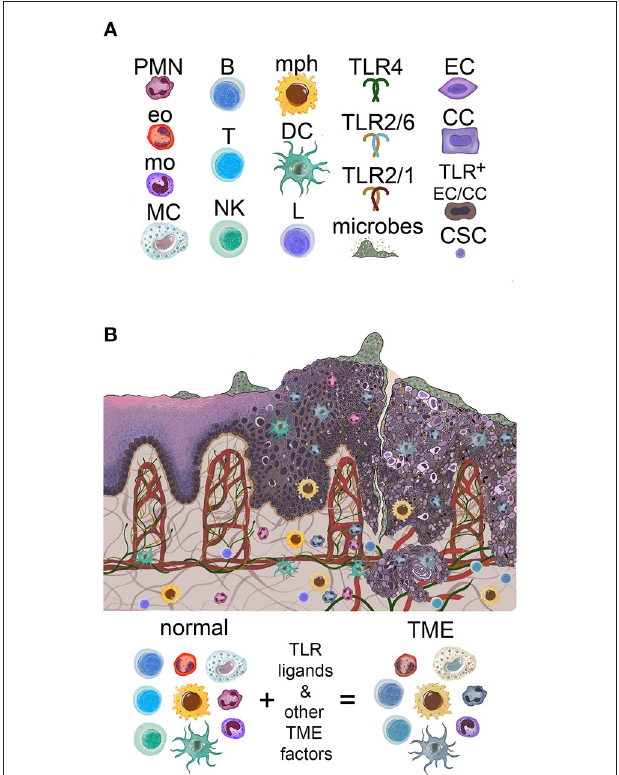
FIGURE 1 | Overview of the oral mucosal environment in the evolution of oral squamous carcinogenesis. (A) Icons used to depict components of the figures in this review. PMN, neutrophil; Eo, eosinophil; mo, monocyte; MC, mast cell; B, B cell; T, T cell; NK, NK cell; mph, macrophage; DC, dendritic cell; L, lymphocyte; TLR, toll-like receptor; EC, epithelial cell; CC, cancer cell; CSC, cancer stem cell. (B) Oral mucosa is colonized by microbes, increasing in amount and penetration with carcinogenesis. Normal basal keratinocytes express high levels of TLR2, possibly both cell-surface and cytoplasmic, according to immunohistochemistry. High levels of TLR2 (as well as TLR5) are found in epithelial dysplasia keratinocytes and OSCC cells. The infiltrating immune system cells increase with progression to dysplasia and OSCC and acquire pro-tumor phenotypes in the TME of established